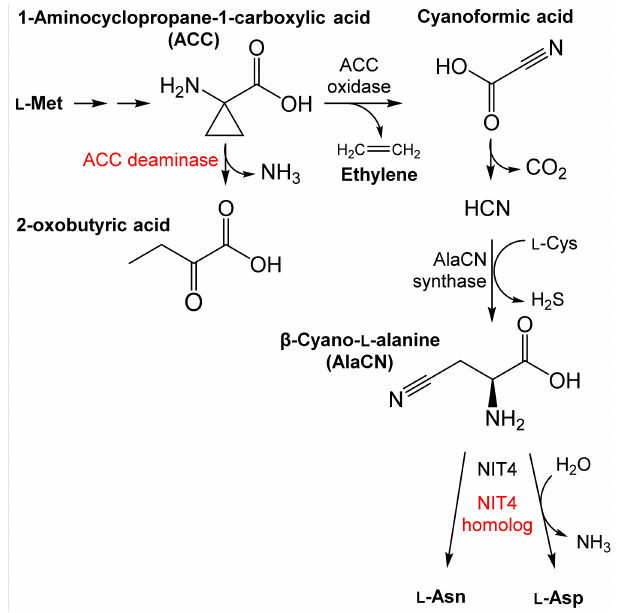
Figure 5. Biosynthesis of phytohormone ethylene in plants and detoxification of the byproduct HCN via β -cyano- L -alanine (AlaCN) (according to [2,52], modified). The synthesis of AlaCN proceeds in plants and, rarely, in bacteria. The hydrolysis of AlaCN proceeds in plants but also in some bacteria and fungi. NIT4, nitrilase specific for AlaCN (plant enzymes in black, bacterial enzymes in red). The Trp-dependent pathways to the phytohormone IAA involve the indole-3-acetamide (IAm), indole-3-pyruvate (IPyA), tryptamine (TAm), Trp side-chain oxidase (TSO), and